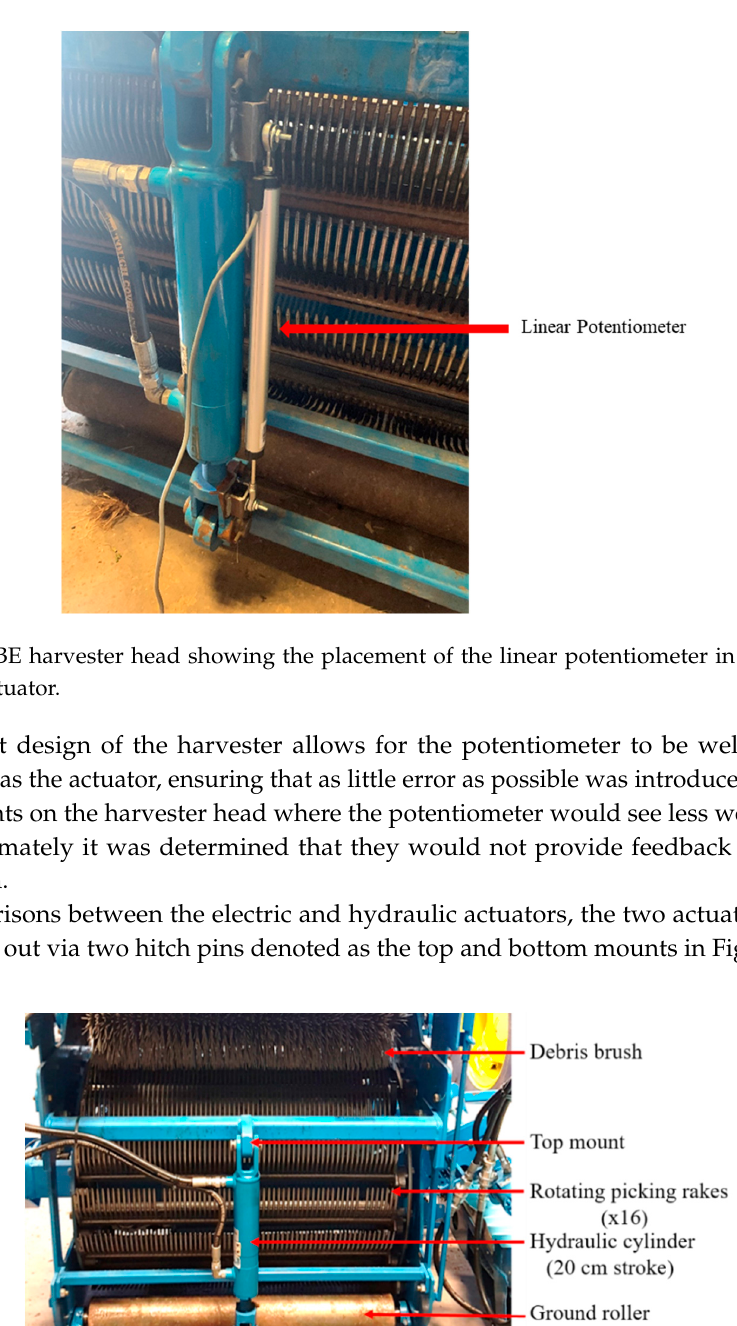
Figure 6. DBE harvester head showing components of the electric actuator setup. 2.4. Lab Evaluation of Electric and Hydraulic Actuators In order to assess the viability of both the electric and hydraulic actuators, a laboratory scale test was used to determine their actuation speeds both under and without load. First, the actuation speed was determined for both actuators when they were disconnected from the harvester head (no load). Being that the full stroke of both actuators is 203.2 mm, the speed is simple to calculate by timing a full stroke. Timing was performed manually and speeds were taken as the average of 16 samples for both the upward and downward stroke directions. Manual timing can introduce some degree of error; however, the speed determination did not require a high degree of accuracy to make a definite conclusion due to the significant difference in operational speeds between the two actuators. The actuators were then attached to the harvester heads (under load) as seen in Figures 5 and 6 and the same analysis was carried out to determine their actuation speeds under load and in both directions. 2.5. Field Evaluation Setup For tests involving comparison between multiple actuators, a hydraulic linear actuator under the load of the harvester head was compared with an electric linear actuator under no load. This was done in order to assess the potential for a linear potentiometer to precisely and accurately provide positional feedback for a hydraulic actuator, similar to what is already incorporated with the electric actuator. The electric actuator was not placed under load as optimal system performance should see negligible differences regardless of load. All data collection was performed in triplicate and were blocked across two fields. The two fields used in this study were Dalhousie’s Wild Blueberry Research Centre’s Western field (45.441248, − 63.451062) and the East Mines’ Northern field (45.427082, − 63.481812) both in Debert, Nova Scotia. All data was analyzed using Fisher’s least significant difference (LSD) multiple means comparison.